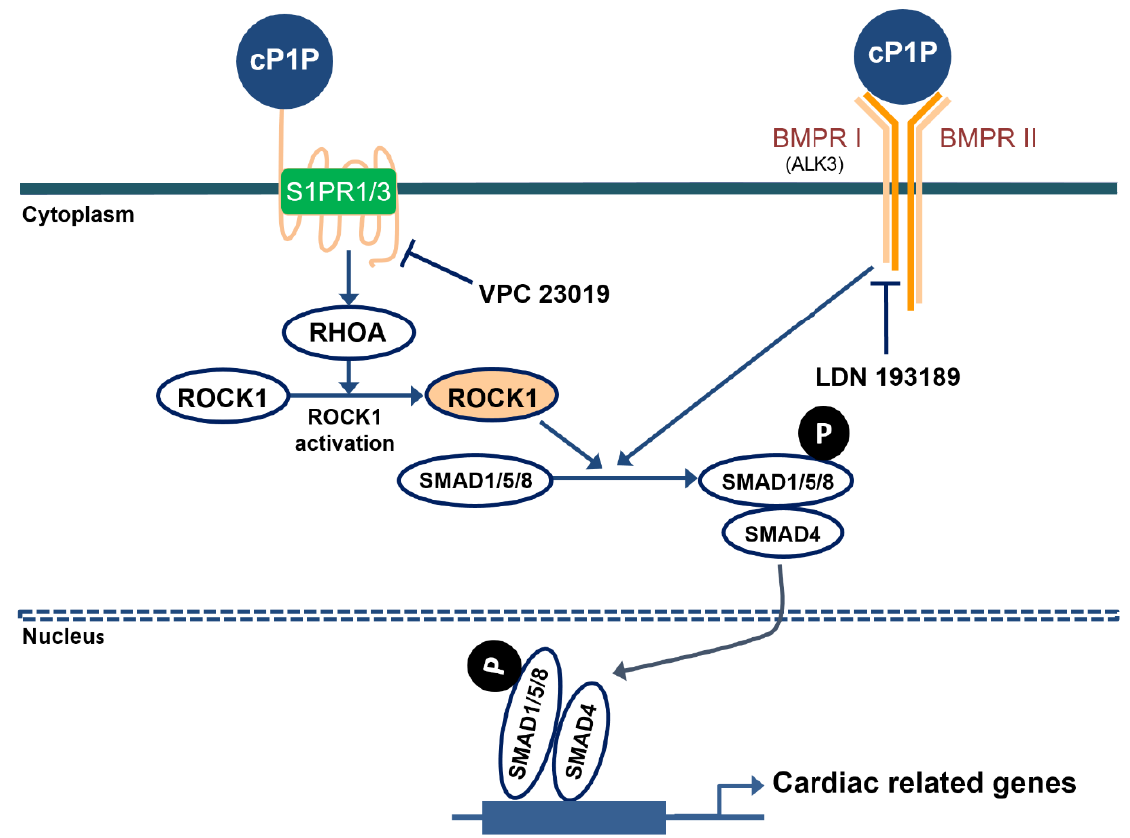
Figure 5. The regulation of SMAD signaling by cP1P during cardiac differentiation. Schematic model of the function of cP1P in regulating cardiac differentiation via the S1PR1/3 and BMPR 1 pathways.